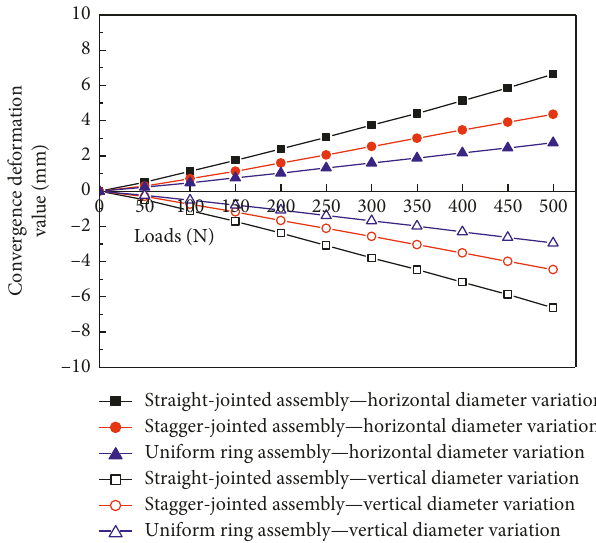
Figure 8: Average variations in diameter of the three repeated tests for each assembly mode under the concentrated loading conditions.